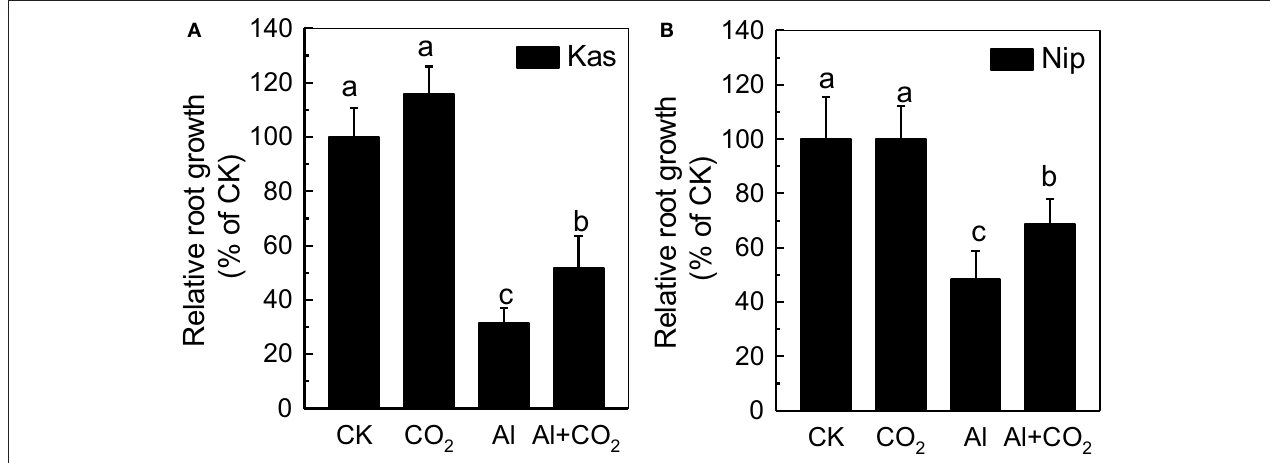
FIGURE 1 | Effects of elevated CO 2 on the relative root growth of “Kasalath” (Kas) (A) and “Nipponbare” (Nip) (B) . Three-day-old rice seedlings were treated with 0.5 mM CaCl 2 solution with or without 50 µ M Al under ambient (400 µ L · L − 1 ; CK) or elevated (600 µ L · L − 1 ; CO 2 ) CO 2 for 24 h (pH 4.5). Root length was measured before and after treatment. Data are means ± SD ( n = 10). Columns with different letters are significantly different at P < 0.05.